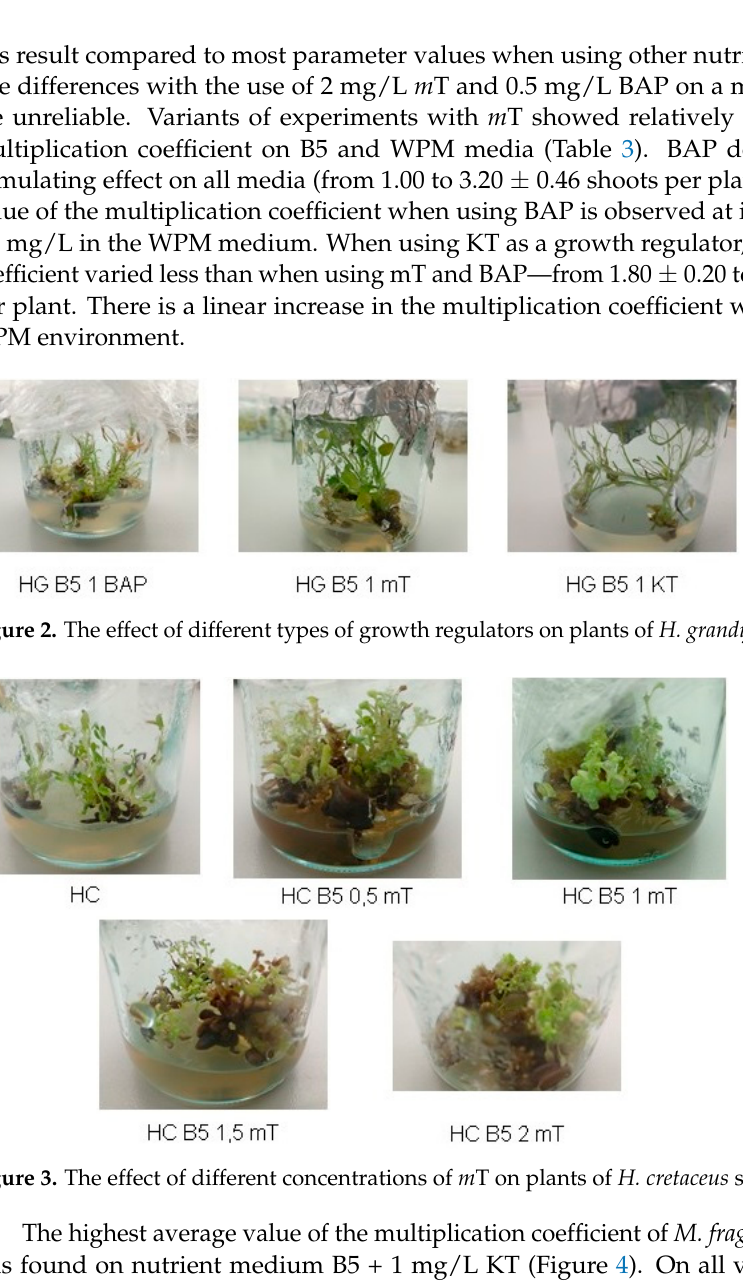
shoots per plant. At the same time, the maximum value of the parameter is fixed at the